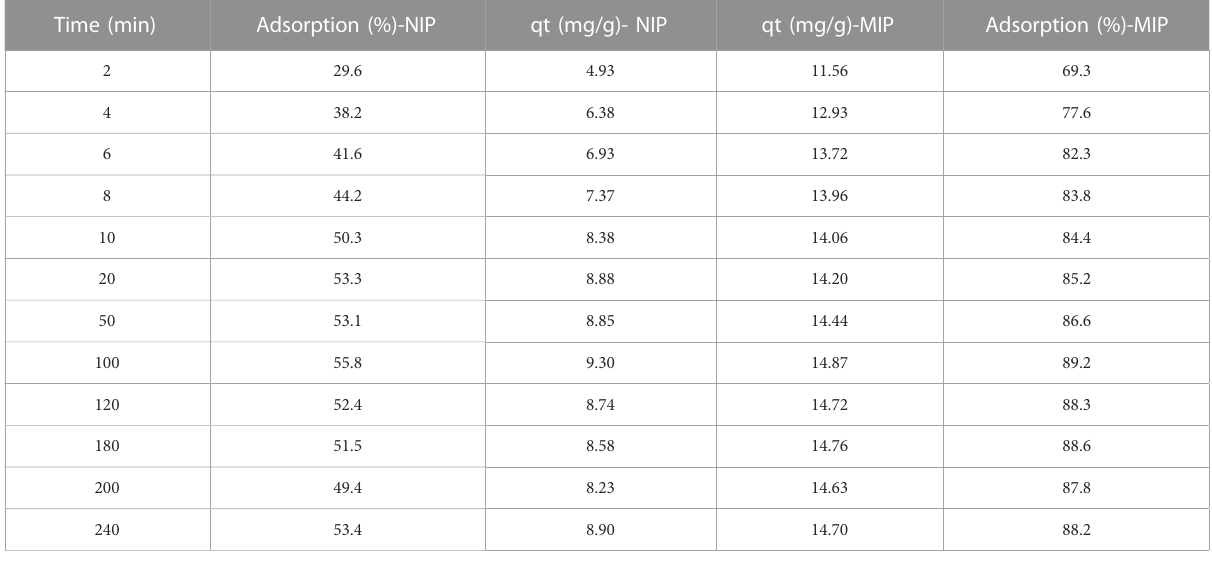
TABLE 2 The amounts of oxycodone drug, taken from the suppernatants of the plasma the MIP and NIP. q t is the concenteration of the drug at time t.